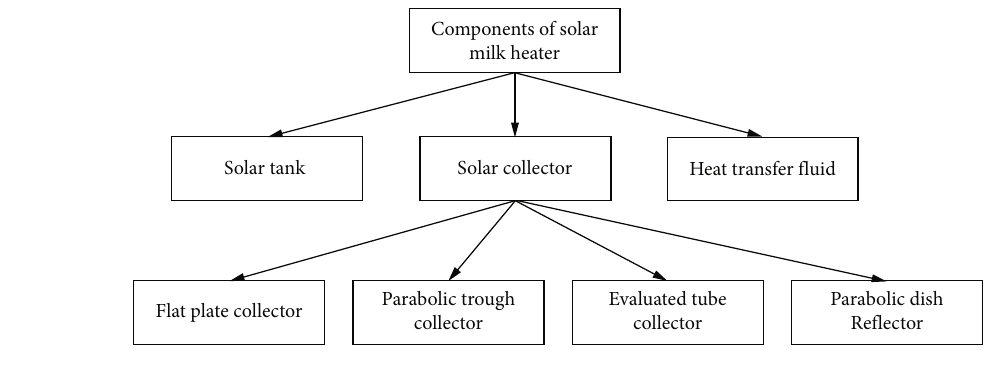
Figure 5: Components for solar milk heater.